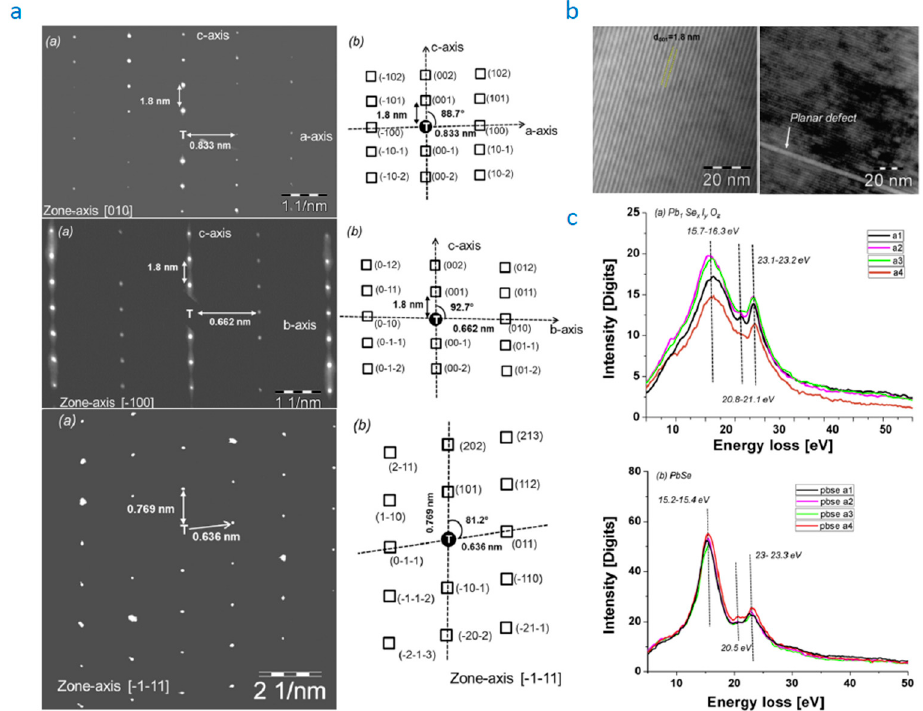
Figure 10. ( a ) Energy-filtered selected area diffraction patterns in the [100], [010], and [111] poles, and the corresponding schematics of the pseudo-orthorhombic crystal structure of the iodized PbSe polycrystalline coatings; ( b ) the high-resolution transmission electron microscopy (HRTEM) images along the c-axis; ( c ) low-loss electron energy-loss spectroscopy (EELS) spectra for distinguishing the PbSe x I y O z phase from PbSe. Reprinted with permission from [81]. Copyright Elsevier 2017.